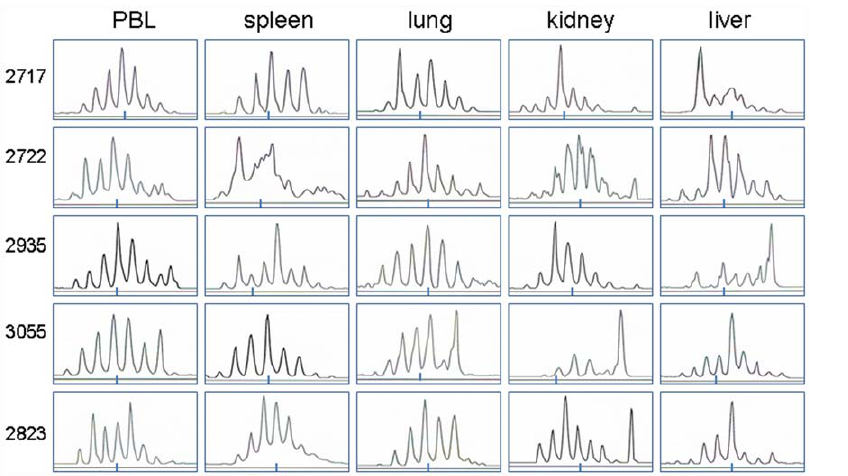
Figure 4. TCR CDR3 spetratyping revealed predominance of a selected CDR3 length in expanded V c 2V d 2 T cells in kidney/liver tissue compartments in late local Mtb infection. Shown are the V d 2 TCR CDR3 profiles revealed by Genescan-based spectratyping as previously described [22]. The numbers of nucleotides in the different CDR3 lengths were determined in control experiments [22], and were expressed as predicted numbers of amino acids. A short line at the bottom of each histogram represents the predicted CDR3 length of 12 aa. The profiles of CDR3 lengths in V d 2 TCR cDNA from blood, spleen and lung of the Mtb-infected macaques were diverse without a restricted selection of a single CDR3 length. In contrast, V d 2 TCR cDNA derived from expanded V c 2V d 2 T cells in kidney or liver tissues of four infected macaques exhibited predominance of a selected CDR3 length. A selected CDR3 length was consistent with the clonal dominance of TCR sequence analyses in Fig. 3.